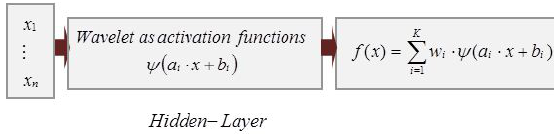
Fig. 1. The wavelet network